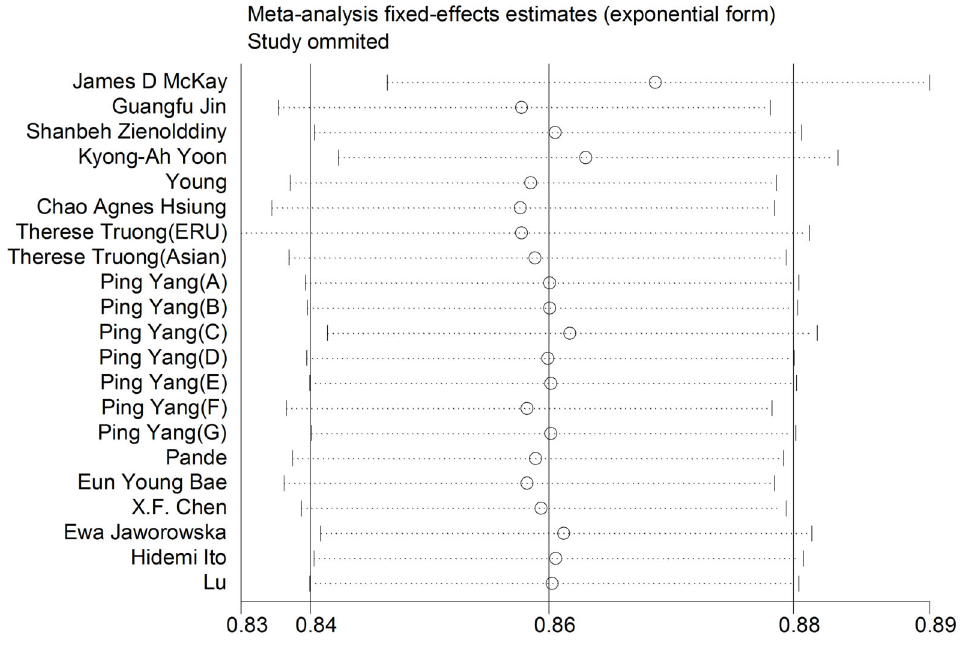
Figure 2. Sensitivity analysis of allelic model.